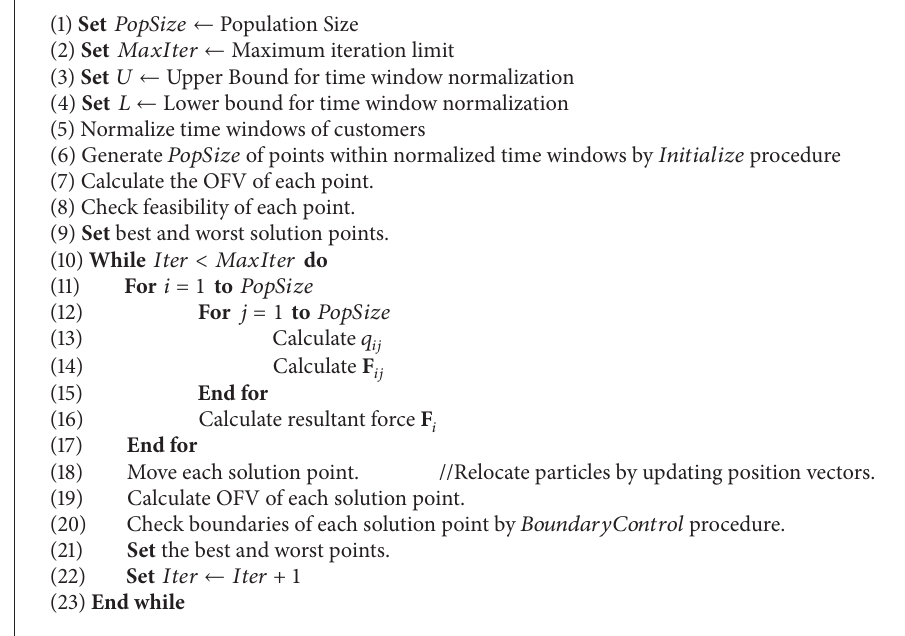
Algorithm 4: General scheme of proposed EMA.